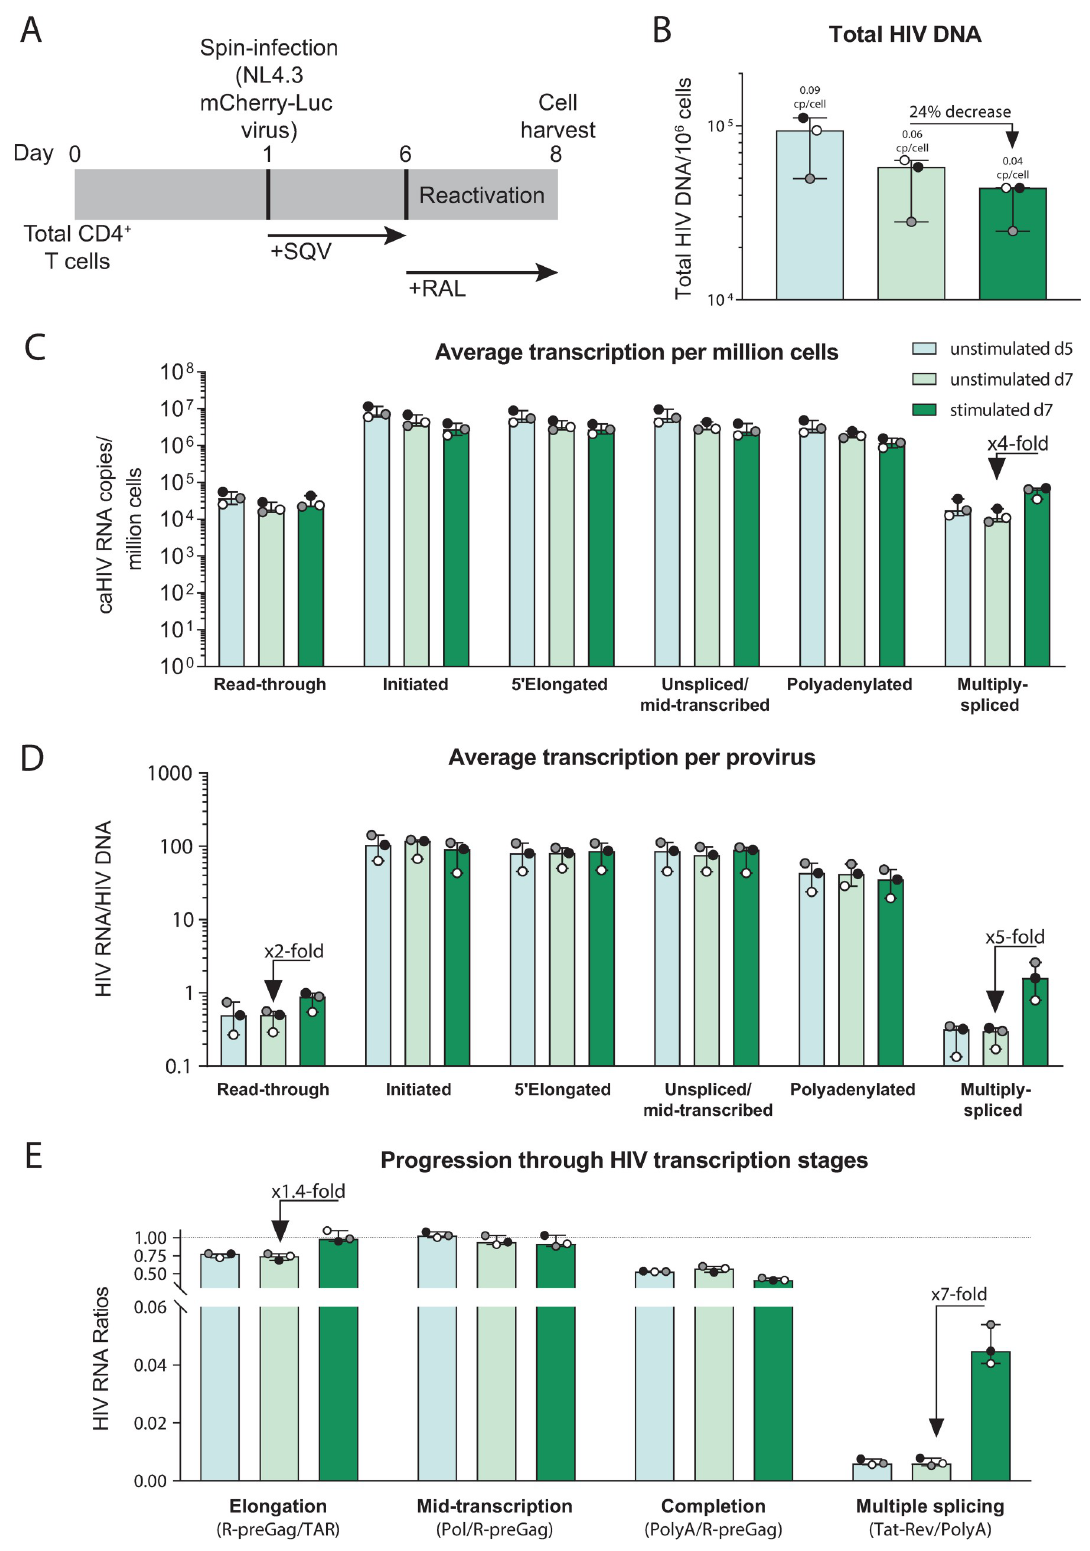
Fig 3. The Resting-cell model: HIV latency is regulated mostly by a block to multiple splicing. (A) Diagram of the model, (B) total HIV DNA, (C) level of HIV transcripts per million cells, (D) level of HIV transcripts per provirus, (E) progression through